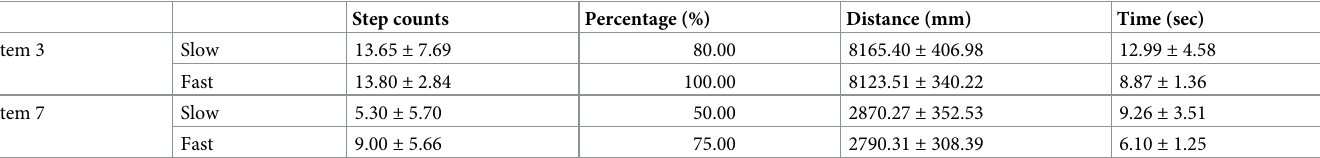
Table 1. Measurement results of Experiment